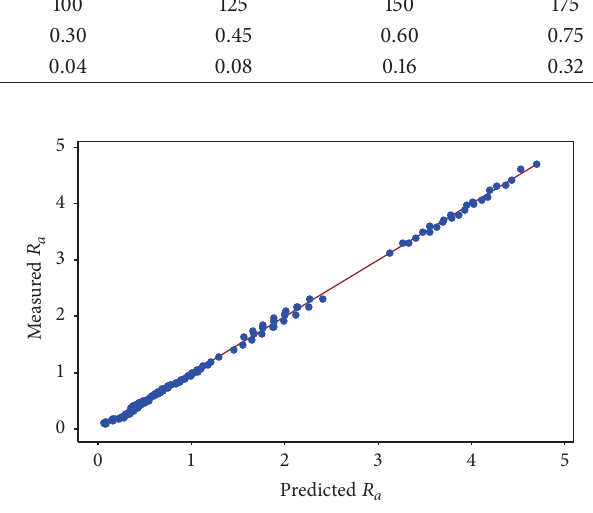
Figure 4: Scatter plot of measured 𝑅 𝑎 versus predicted 𝑅 𝑎